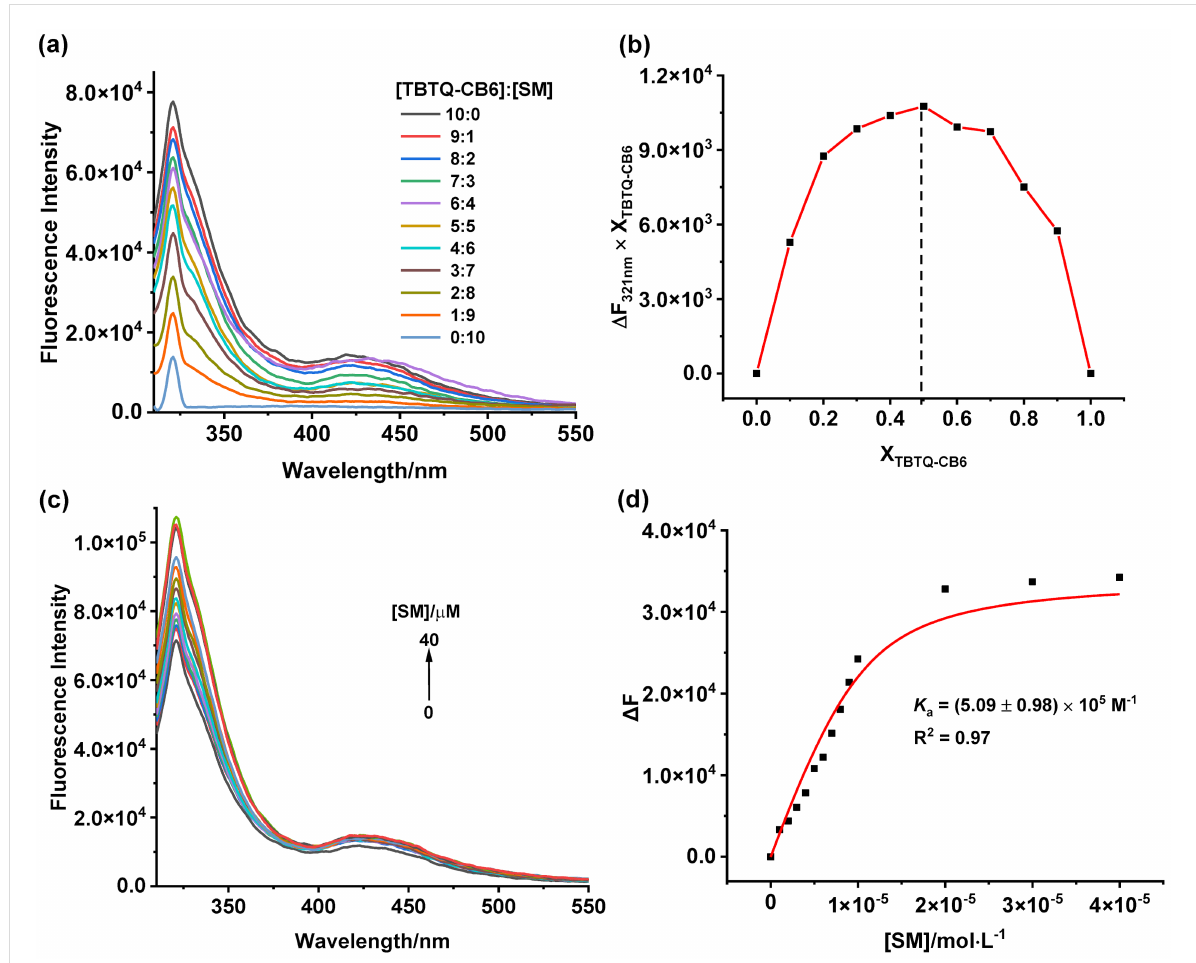
Figure 4: (a) Fluorescence spectra of the mixture of TBTQ-CB6 and SM in different molar ratios at a constant total concentration of 10 μ M. (b) Job plot of TBTQ-CB6 and SM by plotting the difference in fluorescence intensity at 321 nm against the molar fraction of TBTQ-CB6 (X TBTQ-CB6 ). (c) Fluorescence titration spectra of TBTQ-CB6 (10 μ M) with varying concentrations of SM in water ( λ ex = 290 nm). (d) Plot of Δ F vs [ SM ] at 321 nm according to (c) (the solid line was obtained from the nonlinear curve fitting).